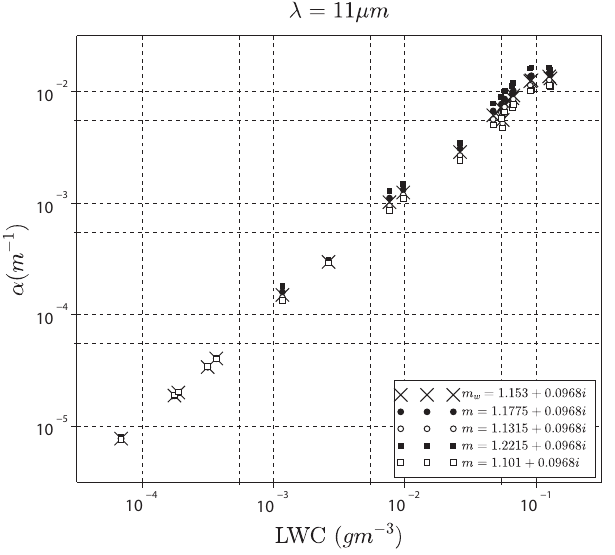
Fig. 11. As Fig. 9, for refractive indices with a variable real part.